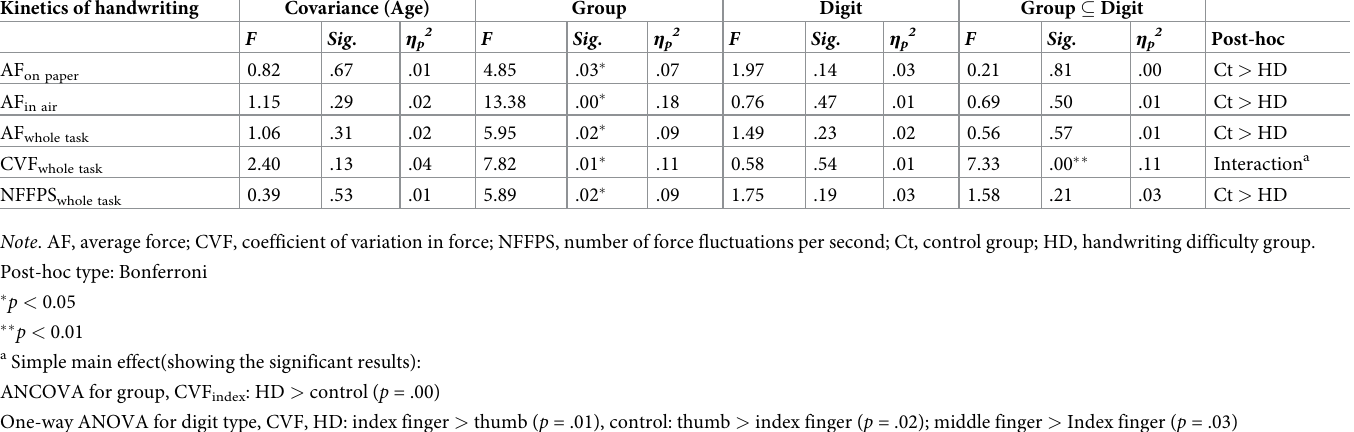
Table 3. ANCOVA summary table for the effects of the digit, group and their interaction. Kinetics of